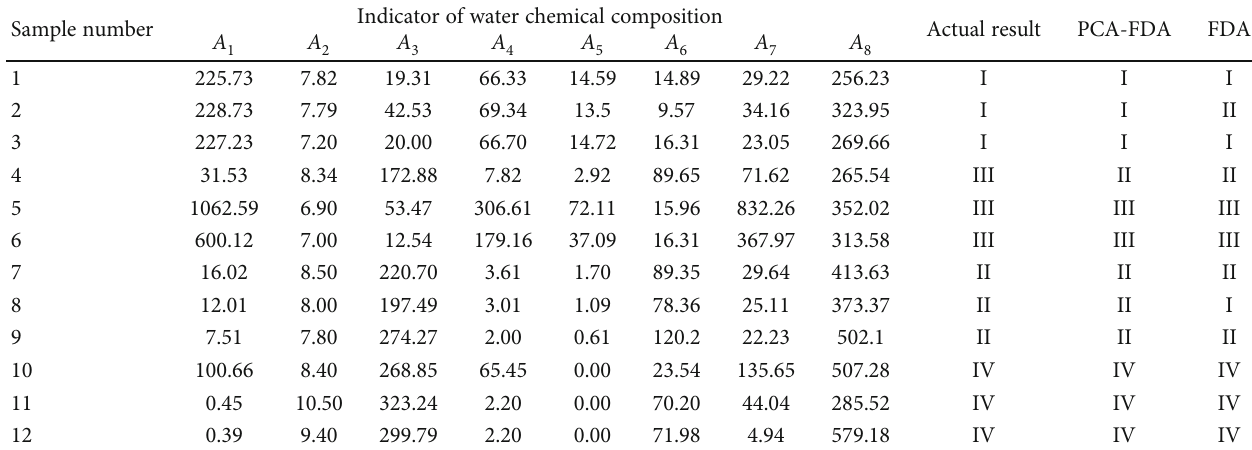
Table 7: Samples to be identi fi ed and identi fi cation results.